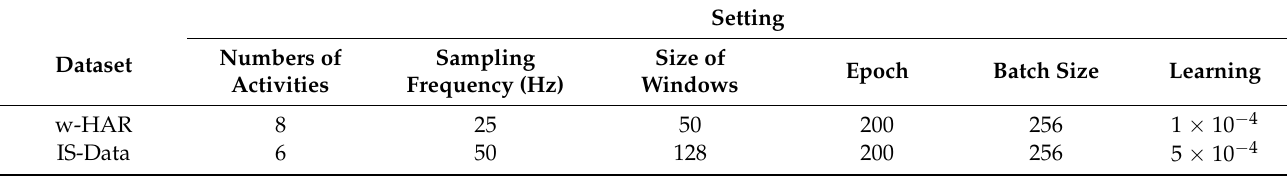
Table 2. Summary of setup for